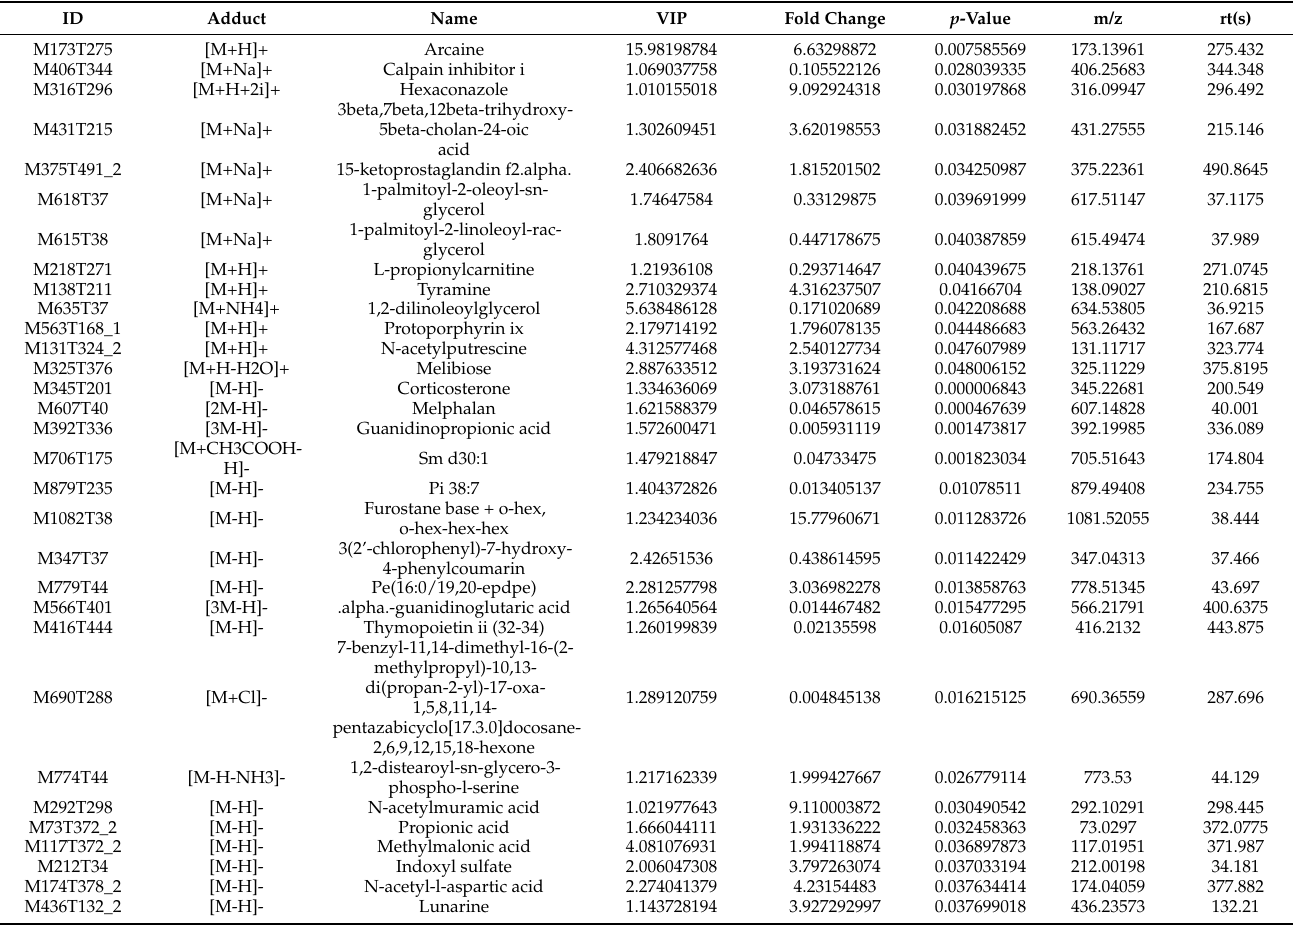
Table 5. Difference metabolites identified by positive and negative ion